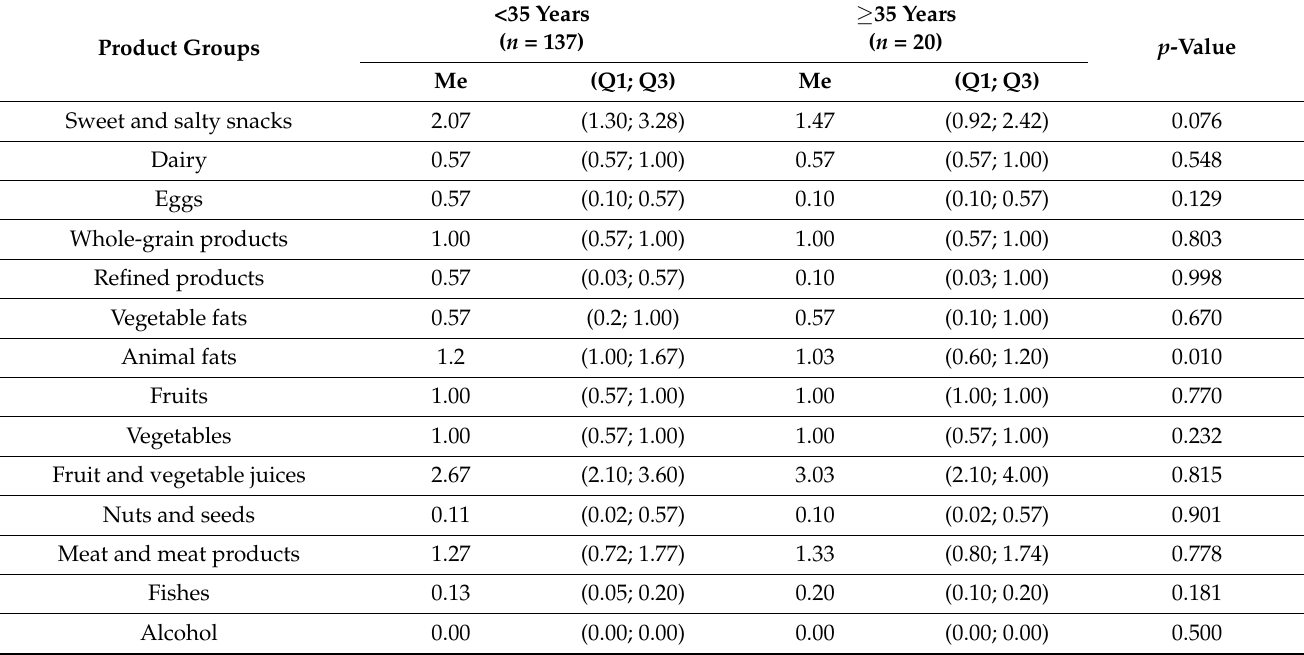
Table 2. The food consumption frequency (frequency/day) of selected product groups depending on the age of surveyed pregnant women.